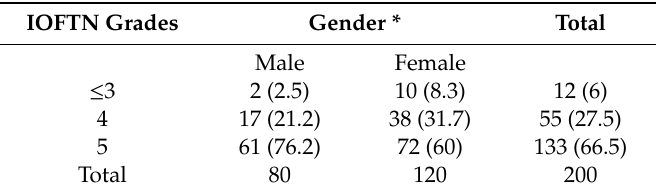
Table 4. Gender distribution of IOFTN grades.